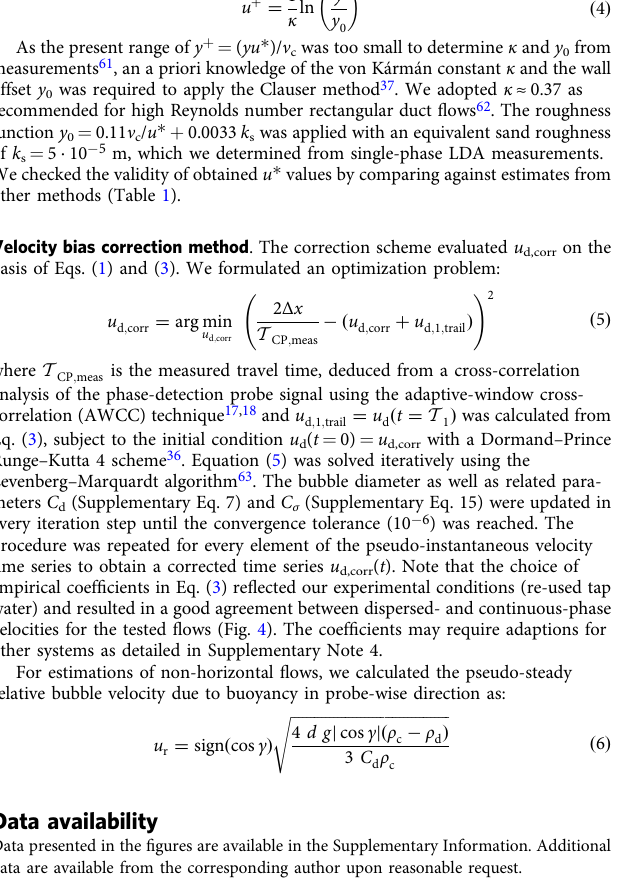
Table 2 Characteristic dimensions of the deployed conductivity (CP) and fi ber-optical (FO) phase-detection intrusive probes.